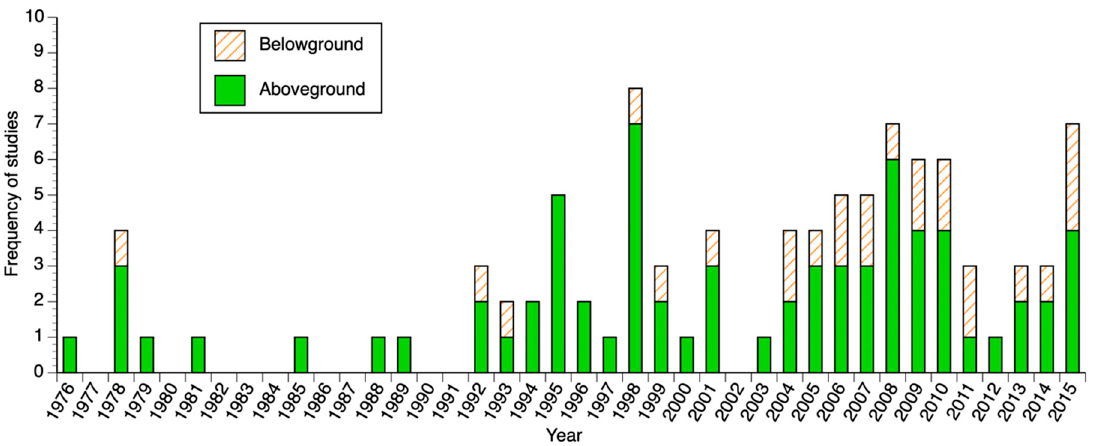
Figure 3. Frequency distribution of wetland vegetation aboveground and belowground ecological studies per year during the period 1976–2015 in coastal Louisiana.